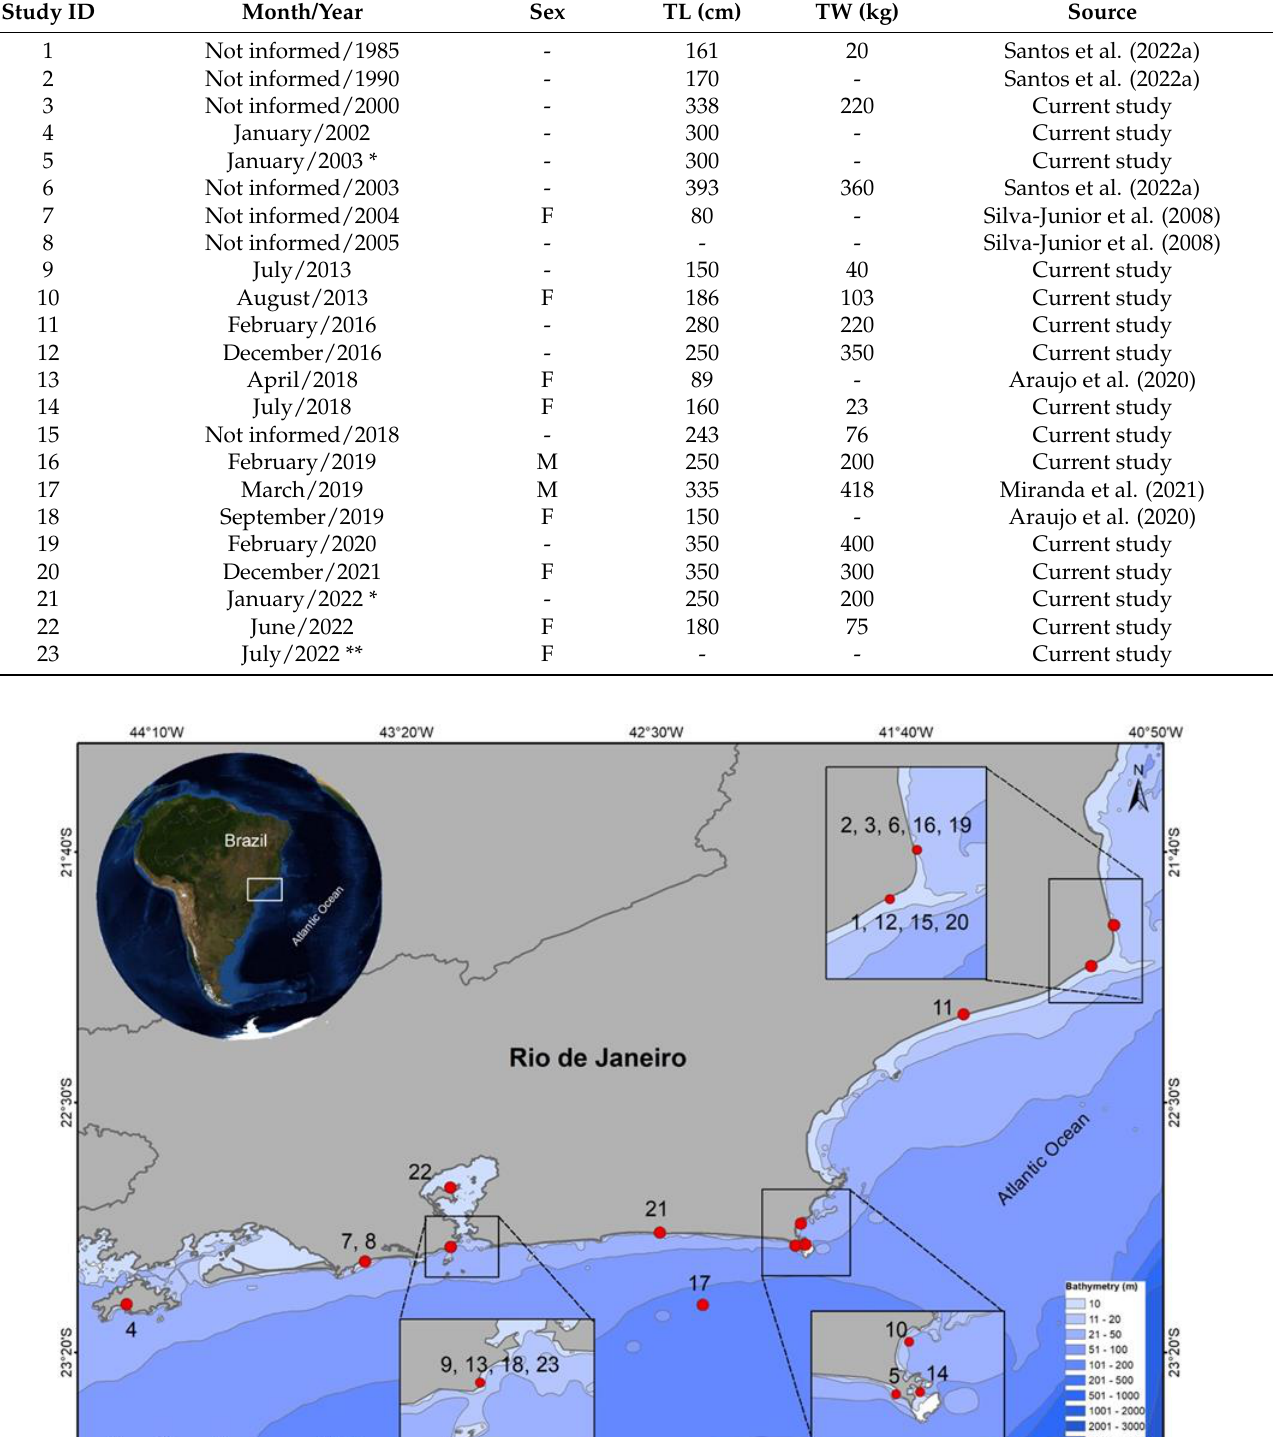
Table 1. Morphometric Galeocerdo cuvier data for the records obtained off the coast of the state of Rio